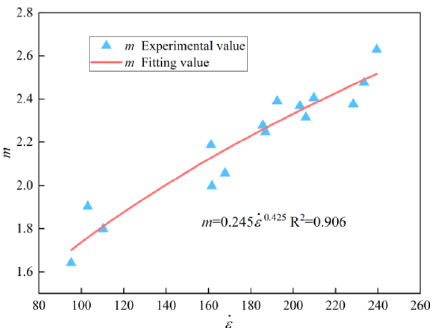
Figure 13. Fitting relationship between m and strain rate.